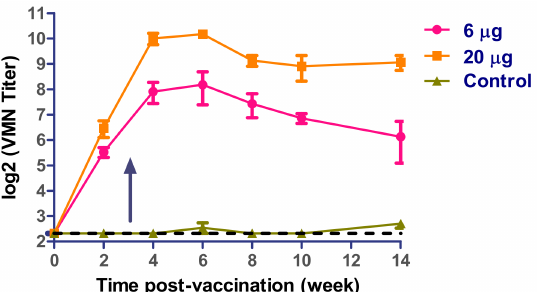
Figure 4. Virus microneutralization (VMN) antibody titers in prime-boost vaccinated mice. Arrow indicates booster